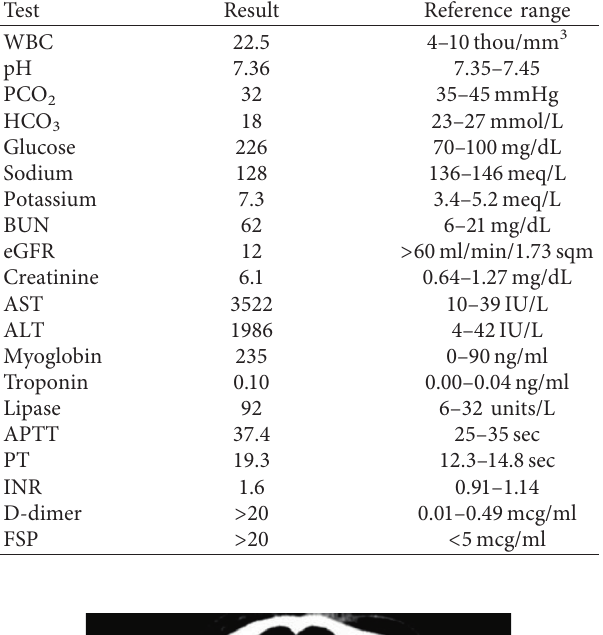
Table 1: Abnormal laboratory test results.